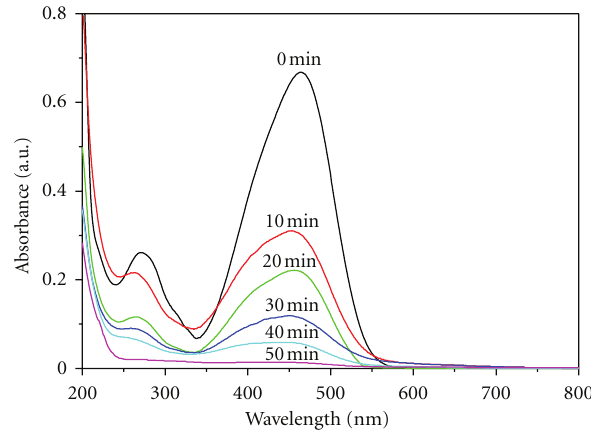
Figure 9: Degradation process of MO by aged TiO 2 under ultraviolet light irradiation, analyzed by UV-Vis absorption spectra for solutions separated from the TiO 2 suspensions irradiated for di ff erent periods.